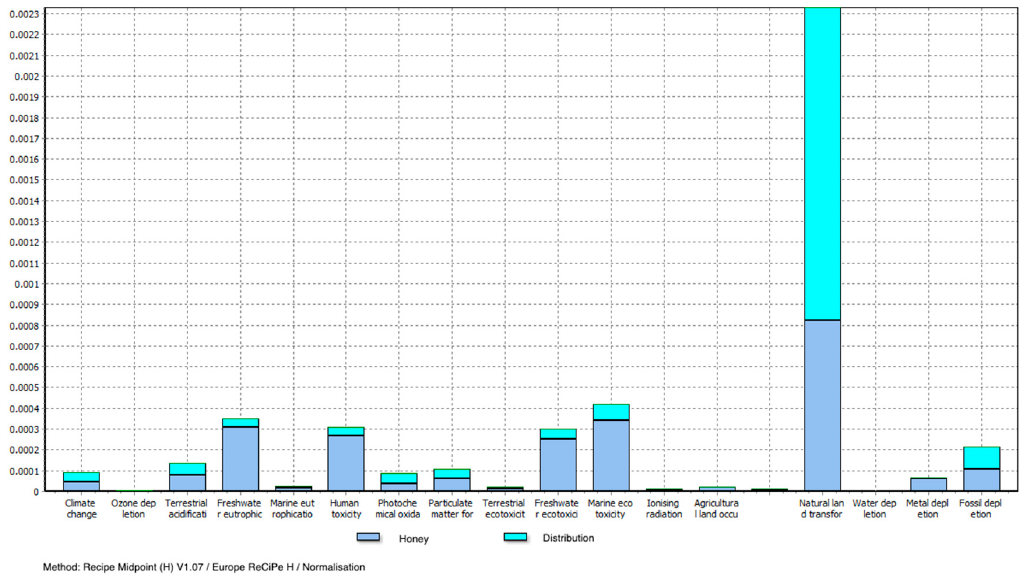
Figure 3. Normalisation results for the 30% assumption—extracted from SimaPro (Pré 2018).